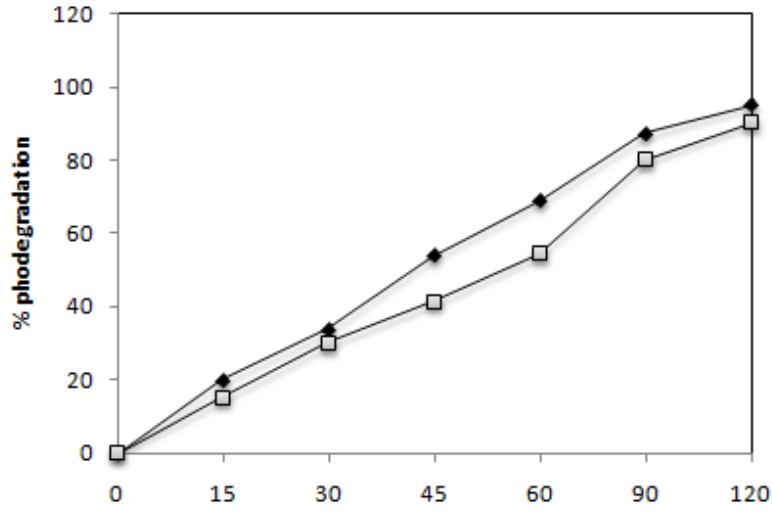
Figure 2. Effect of UV-Irradiation time on the degradation of 30 mg·L − 1 of the azo dyes C.I. Reactive Red 239 ( ) and C.I Reactive Black 5 ( ) with 0.1 g·L − 1 of TiO 2.60 mW/cm 2 of irradiation power by a 125 W mercury lamp.